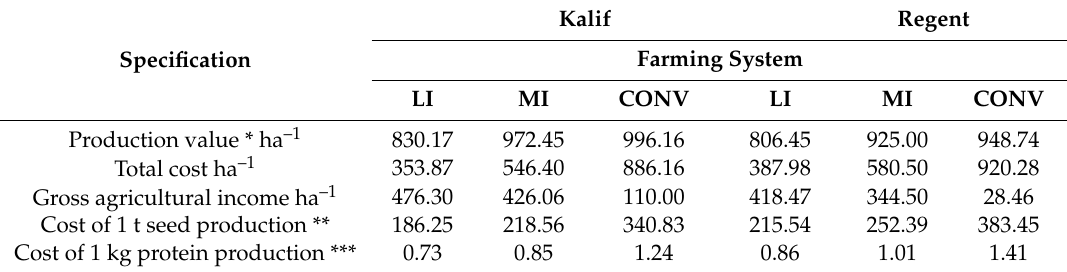
Table 6. Economic analysis of the profitability of narrow-leaved lupin cultivation under di ff erent farming systems (all values expressed in